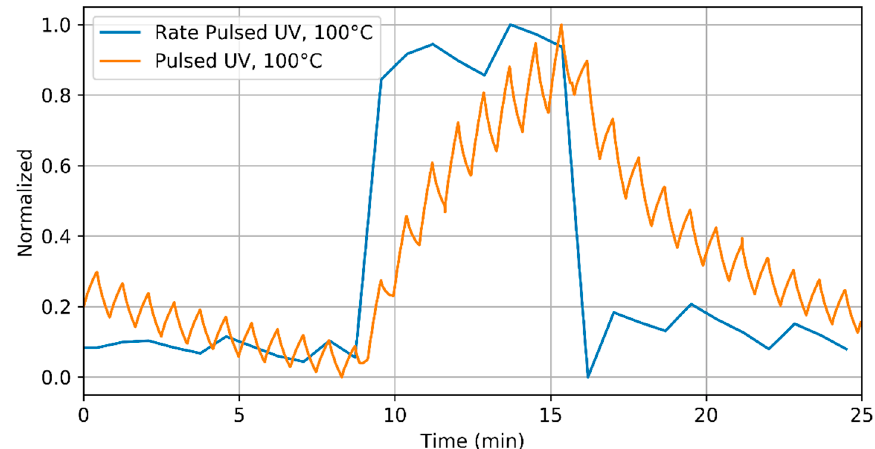
Figure 3. Detail of the sensor response to NH 3 , 5 ppm, when operated at 100 °C under pulsed UV light and the corresponding evaluated rate. Both appear normalized for clarity.